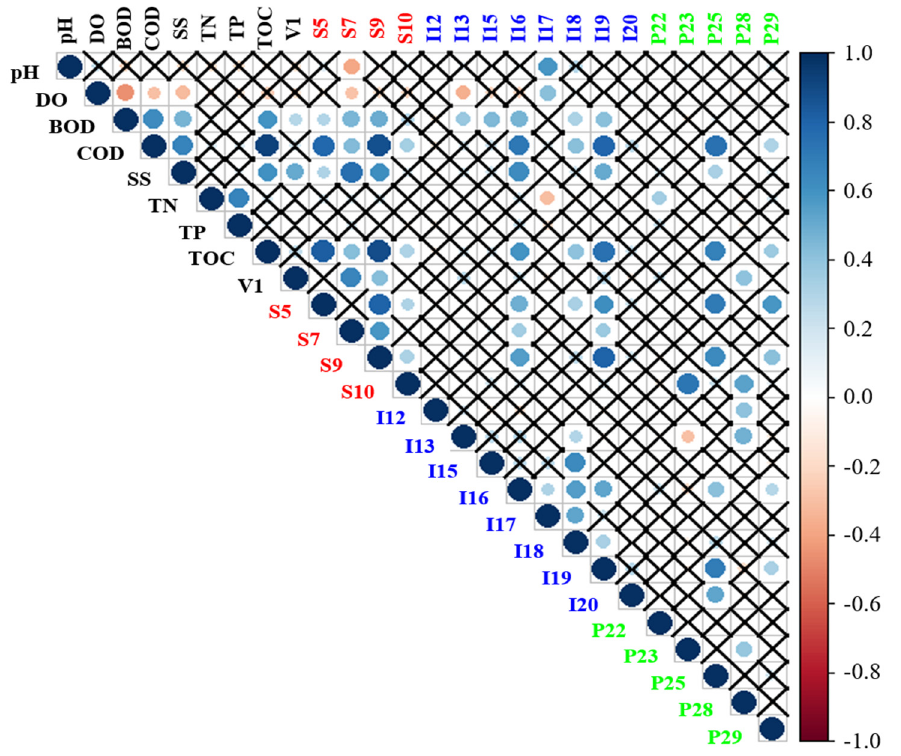
Figure 6. Pearson correlation between water quality indicators and hazardous substances. The size and color of the circles indicate the correlation coefficient values, and the cross indicates statistical insignificance ( p > 0.05). (V; VOCs, S; SVOCs, I; Inorganic matters, P; Pesticides, the number after the alphabet indicates each hazardous substance, see Table 1).